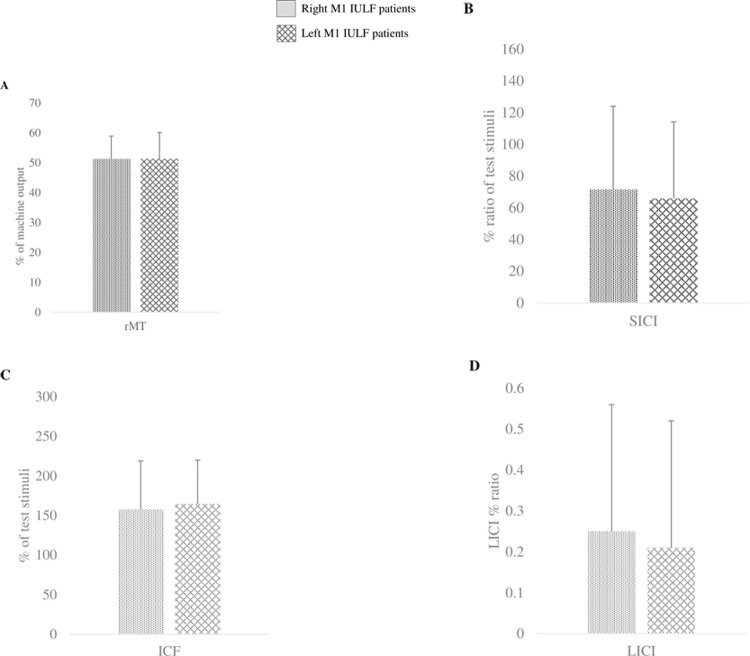
Between IULF-group differences on TMS measures stratified according to the stimulated hemisphere.A. Between IULF-group differences on rMT stratified according to the stimulated hemisphere. B. Between IULF-group differences on SICI stratified according to the stimulated hemisphere. C. Between IULF-group differences on ICF stratified according to the stimulated hemisphere. D. Between IULF-group differences on LICI stratified according to the stimulated hemisphere.